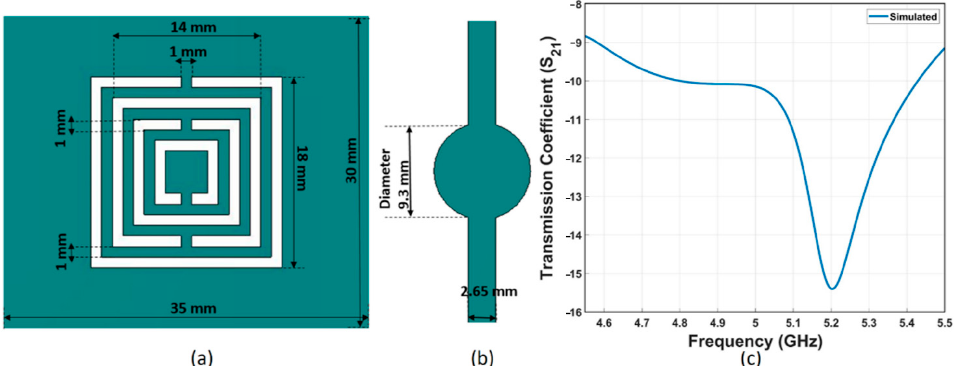
Figure 1. ( a ) Four-ring resonator in the ground plane of the sensor. ( b ) Feed line of sensor. ( c ) Transmission coefficient (S 21 ) at different frequencies.